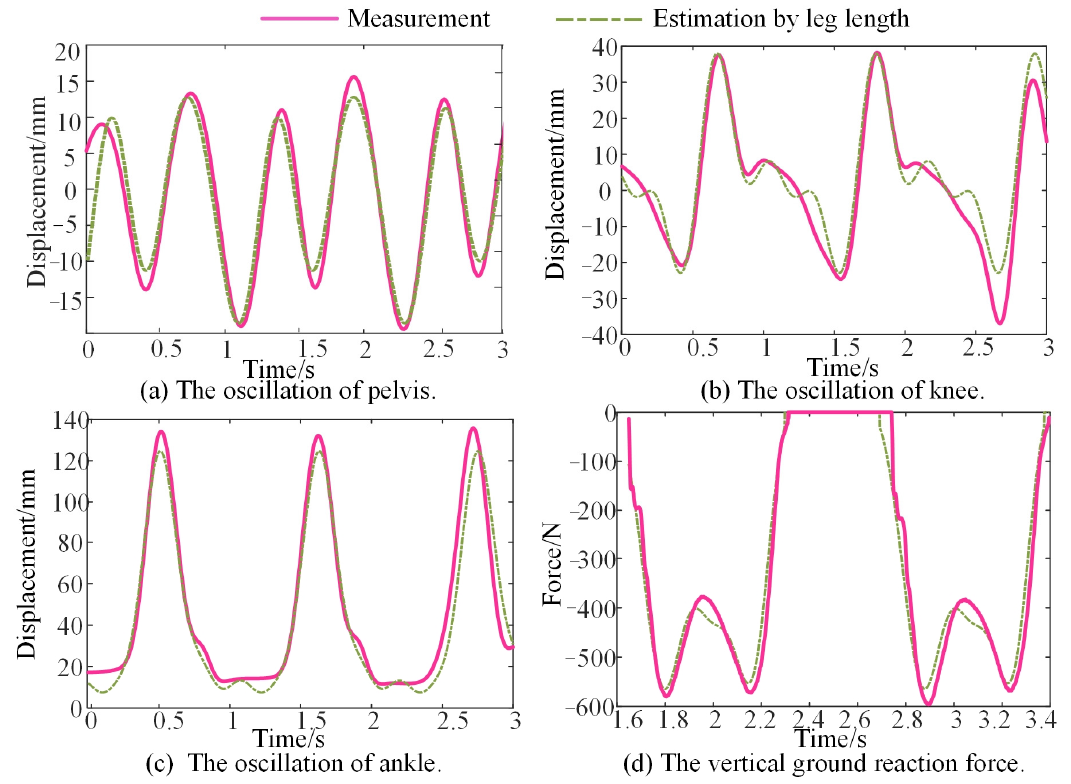
Figure 7. Comparison of vertical displacement between the measurement and the estimation by the individual parameters.